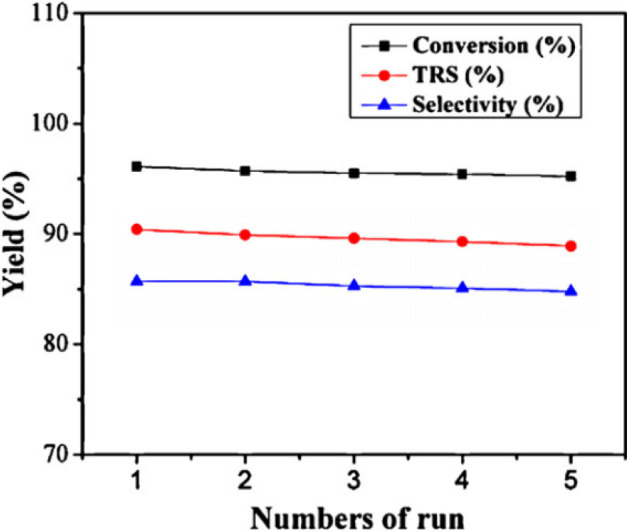
Recycling test of the [C16H33N(CH3)3]H2PW12O40 catalyst. Reaction conditions: 0.1 g cellulose, 0.07 mmol catalyst, 7 mL water, 170°C for 8 h. Reproduced with permission from Cheng et al. (2011).